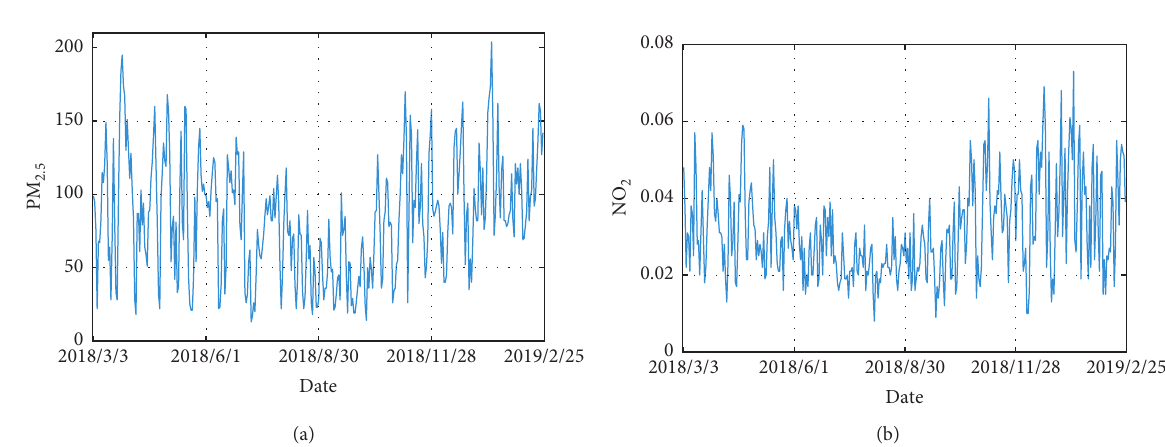
concentration and (b) NO 2 . 5